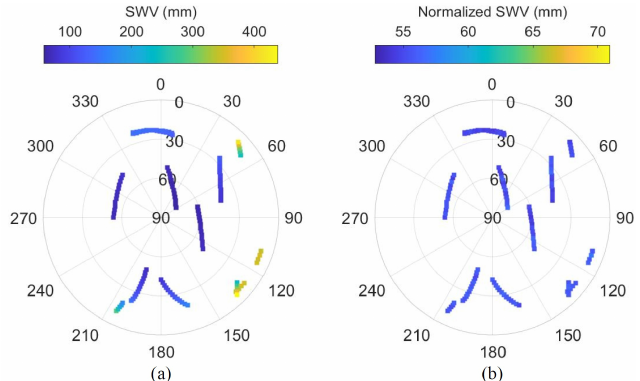
Figure 3. Skyplots of ( a ) SWV and ( b ) normalized SWV on 21 April 2016, 09:00 to 10:00 local time.